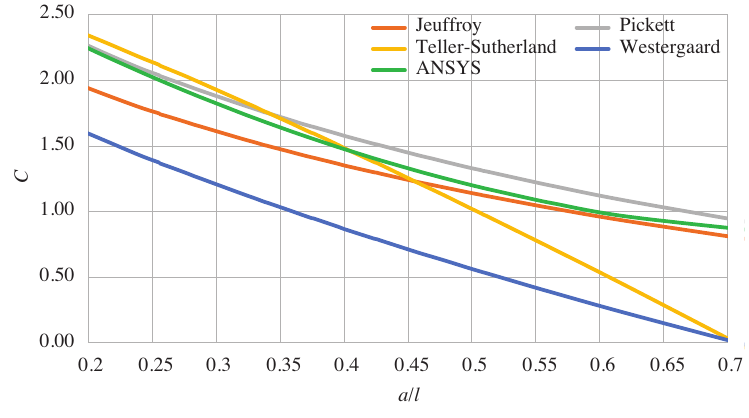
Figure 15. C values within different theories as a function of a / l ratio